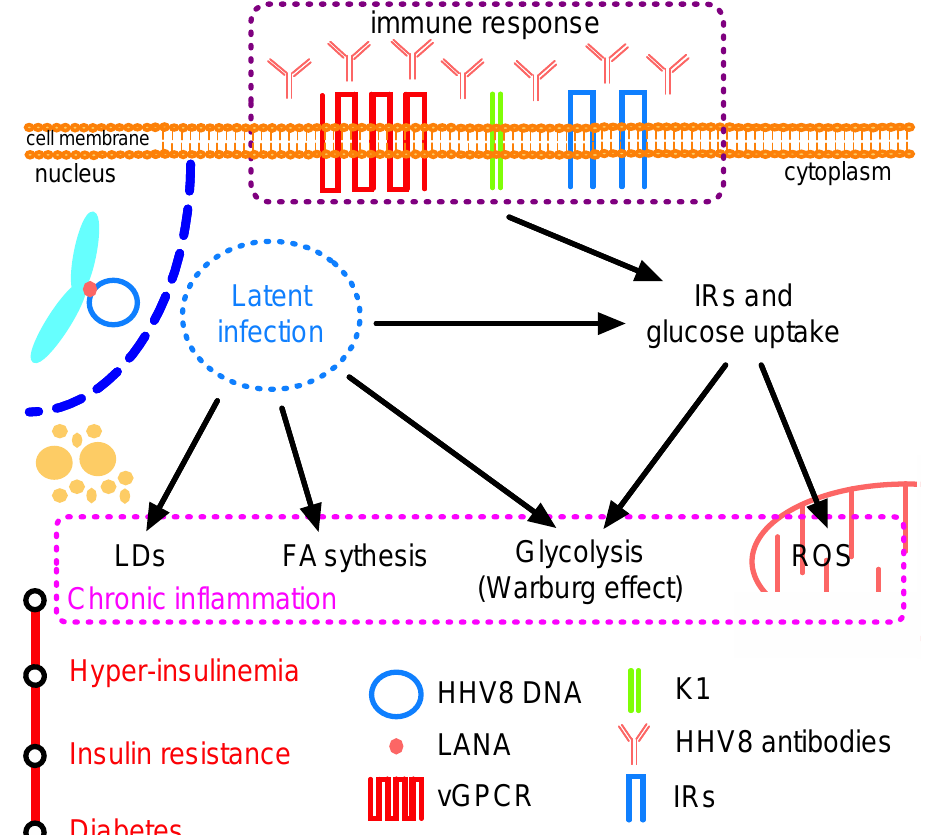
Figure 1. Schematic representation of the HHV8-induced metabolism alteration of endothelial cells and the hypothetical association with diabetes type 2 development. Latent-persistent HHV8 infection, together with the humoral immune response, induces a strong enhancement of insulin receptors (IRs) with a consequent increase in glucose uptake that skews the cell metabolism toward the anaerobic glycolysis that leads to lactate accumulation (Warburg effect). The higher glucose concentration and the hypoxic condition trigger mitochondrial ROS production. Moreover, the latent infection also stimulates fatty acid (FA) synthesis and the accumulation of neutral lipids in cytoplasmic lipid droplets (LDs). Overall, in a body metabolism context, these alterations may evolve into chronic systemic inflammation with the higher IRs expression further stimulating insulin production by pancreatic beta-cells and the feasible induction of hyper-insulinemia that, time by time, may lead to insulin resistance and hence to diabetes type 2.